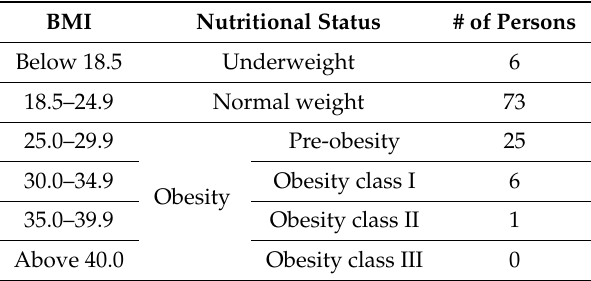
Table 1. Number of people for each nutritional